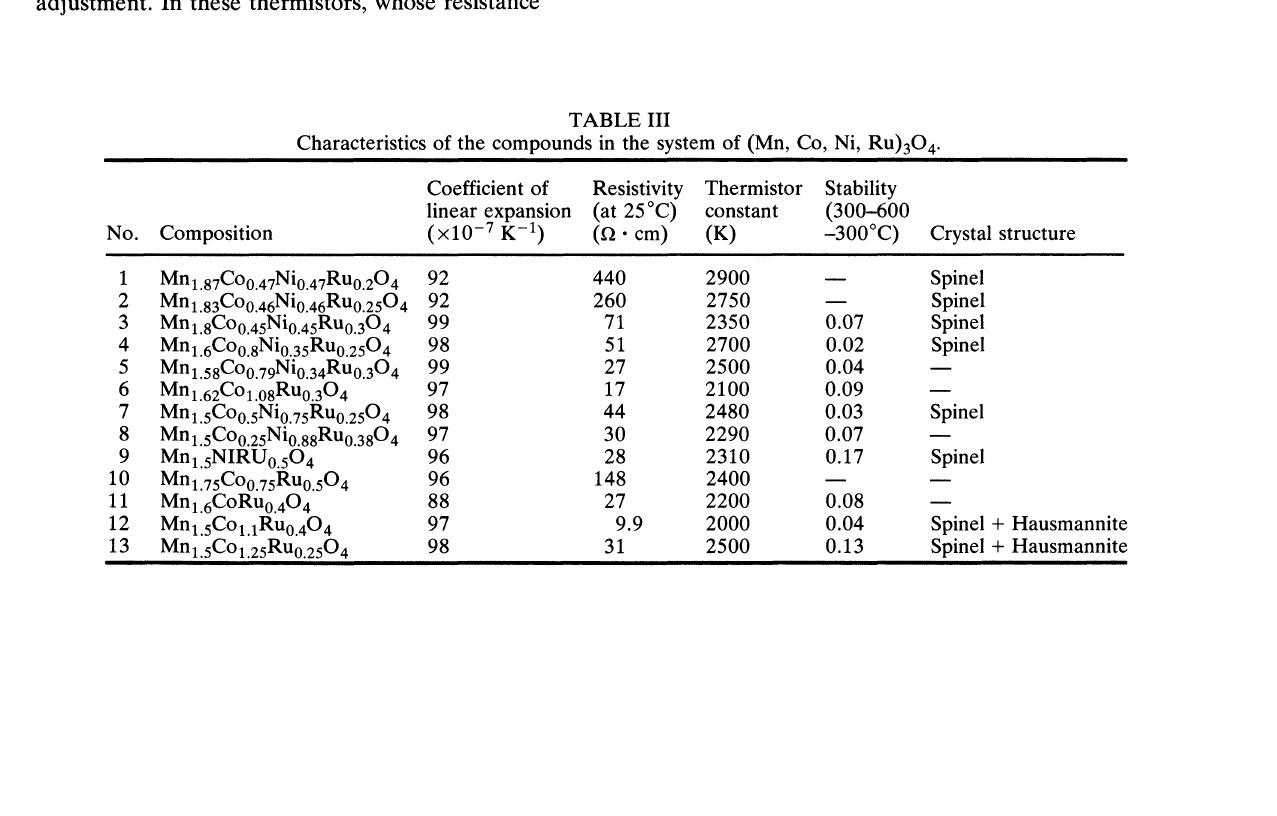
FIGURE 7 Effects of RuO thermistor constant of the Mnl.6Coo. Nio.35Ruo.250